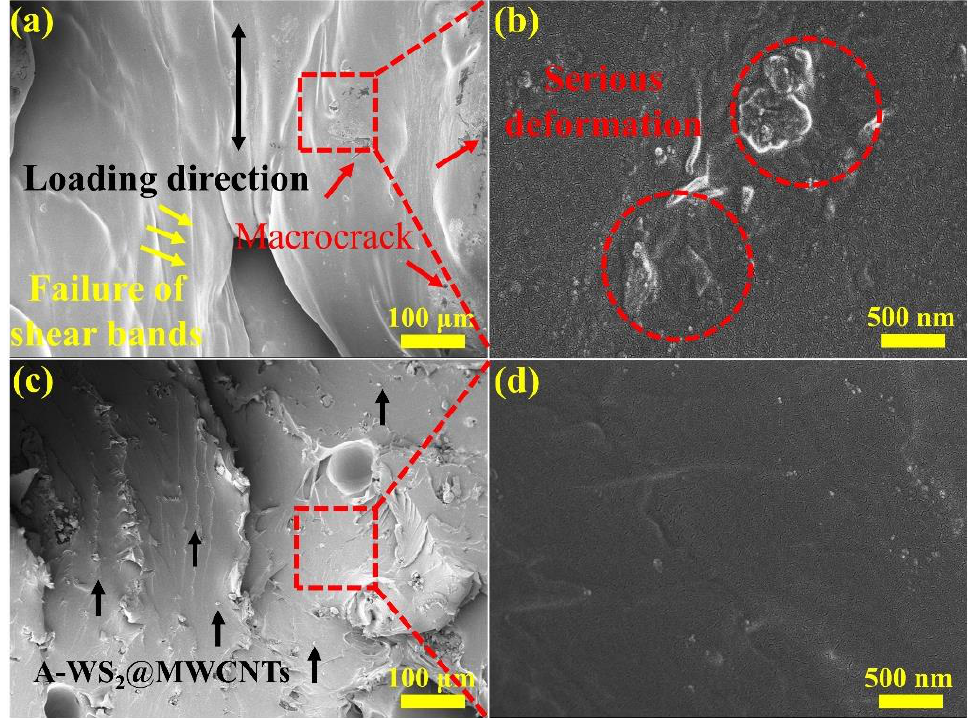
Figure 8. ( a , c ) SEM images of ( a ) pure PUE and ( c ) A-WS 2 @MWCNTs/PUE fracture, and ( b , d ) SEM images corresponding to the selected area in ( a , c ). Figure 9a – d shows the surface morphology of pure PUE and 1.5%A-